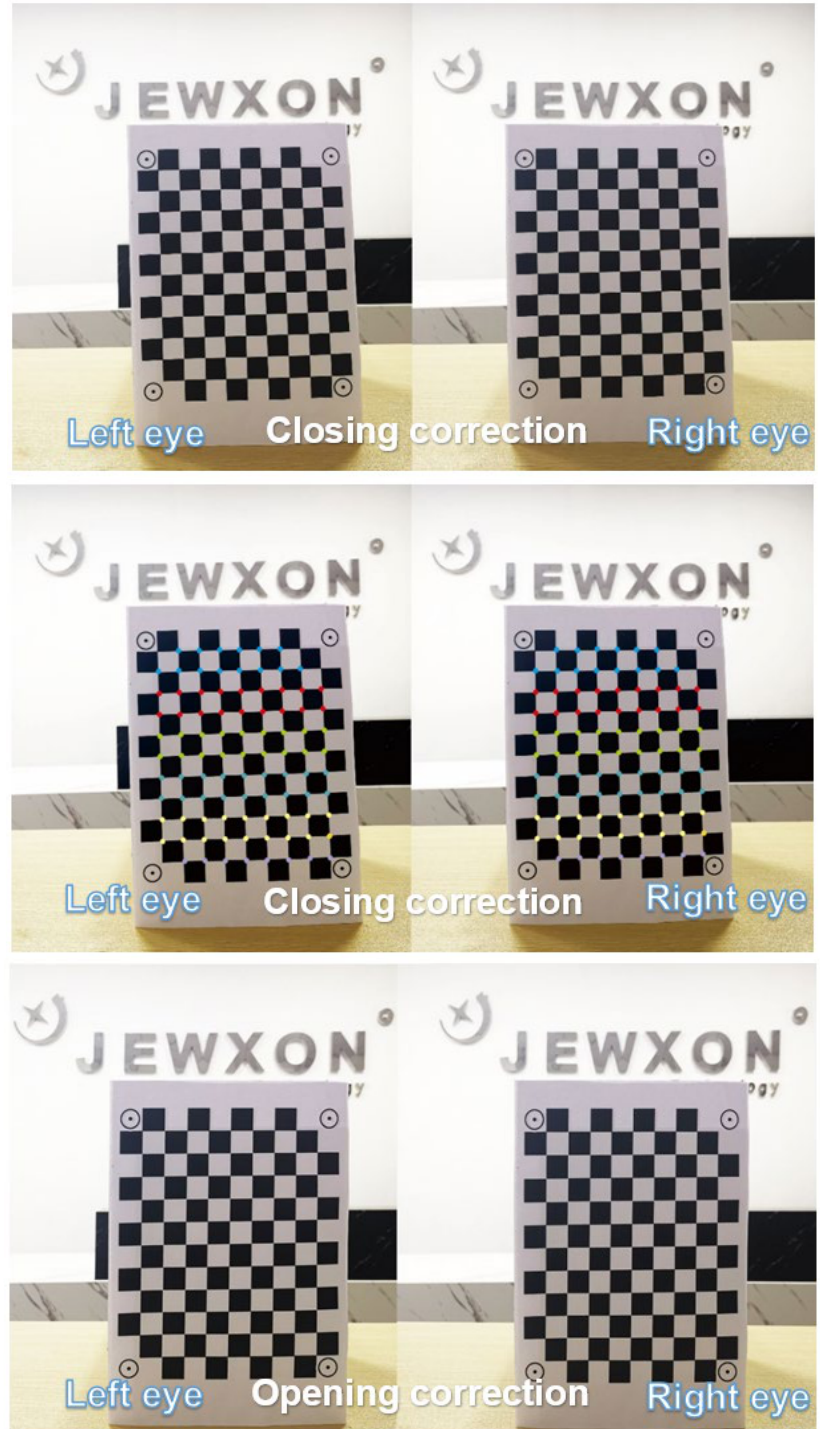
Figure 18. Comparison of visual effects of posture correction systems in interference.